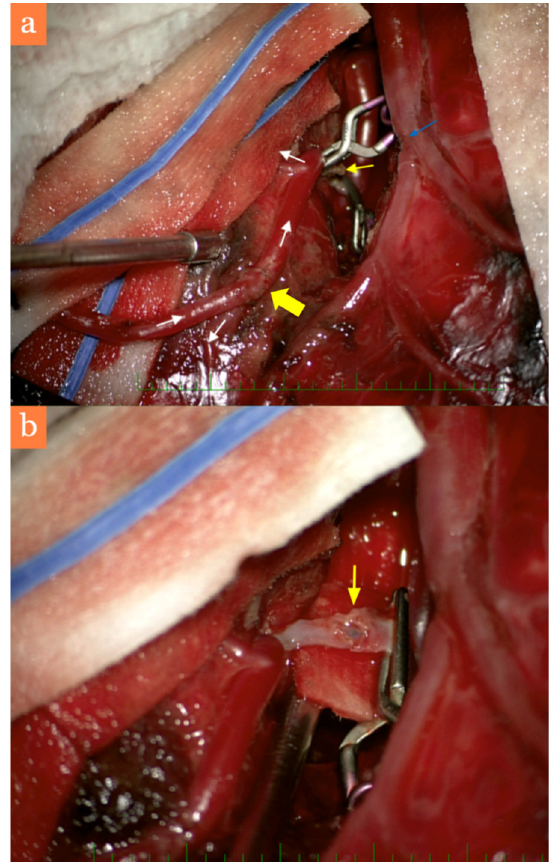
Figure 2. Intraoperative situations ( a ) final aneurysm treatment: extra-intracranial (EC-IC) (super- ficial temporal artery–middle cerebral artery (STA-MCA) M4) bypass (white arrows showing the direction of flow, site of the anatomosis has wide yellow arrow), aneurysm trapping (thin yellow arrow), sylvian fissure dissection with suturing of a superficial sylvian vein branch (blue arrow), primary insult of the cerebral parenchyma via an acute subdural and intracerebral hematoma, ( b ) detailed dissection of the M3 arterial wall.